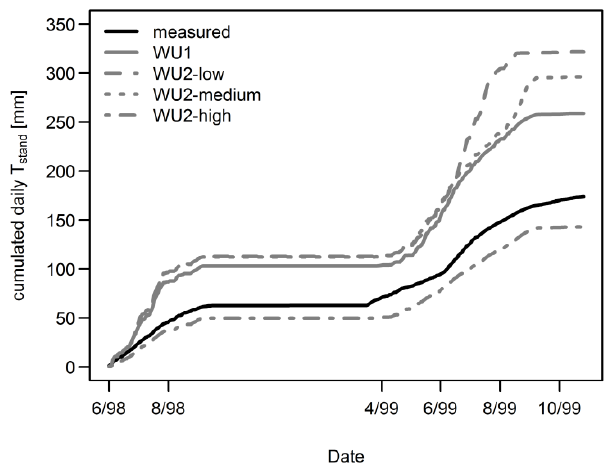
Figure 2. Measured and simulated transpiration of P1 site. Simulated transpiration with WU2 involves three different values for root resistance (low, medium, high).